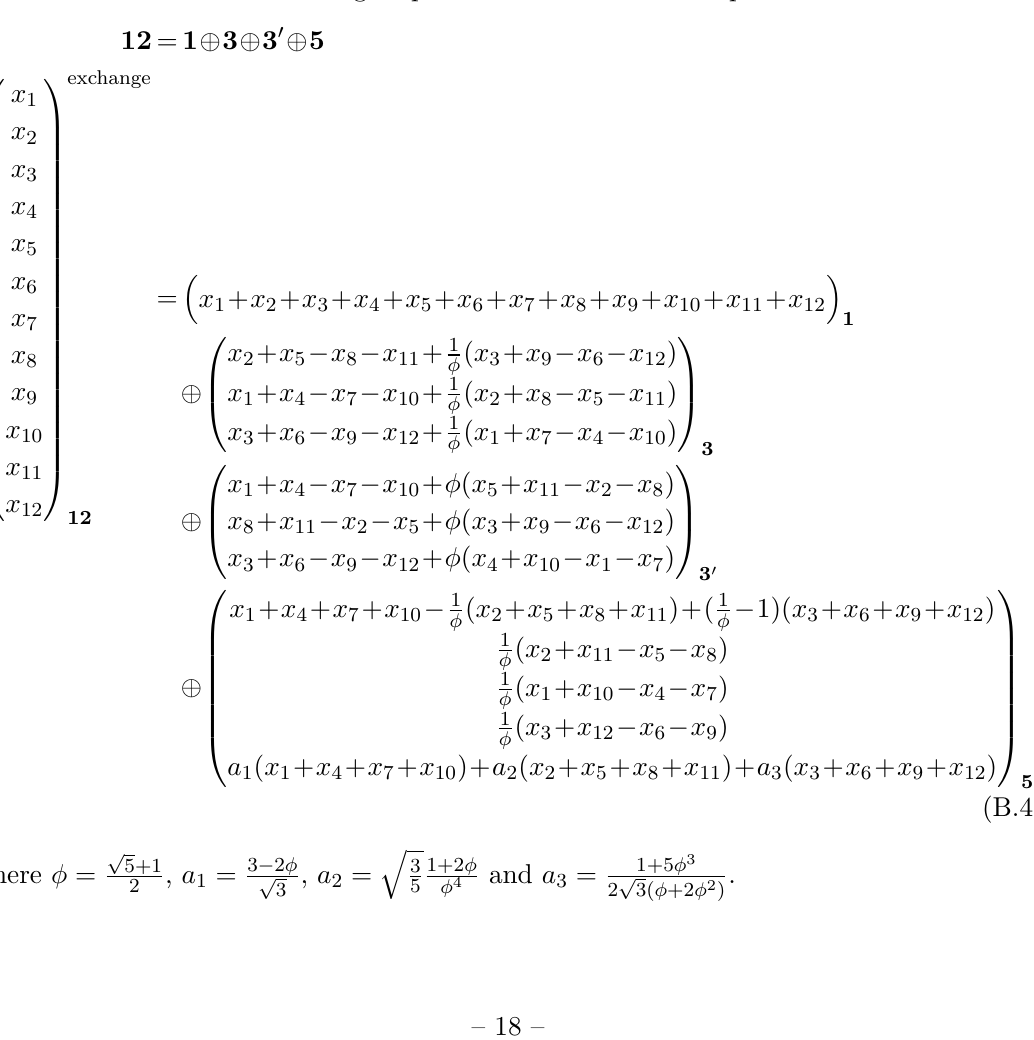
5 . A 5 can be parameterized by [19] ( x 2 , x 1 , 7! ( x 2 7!